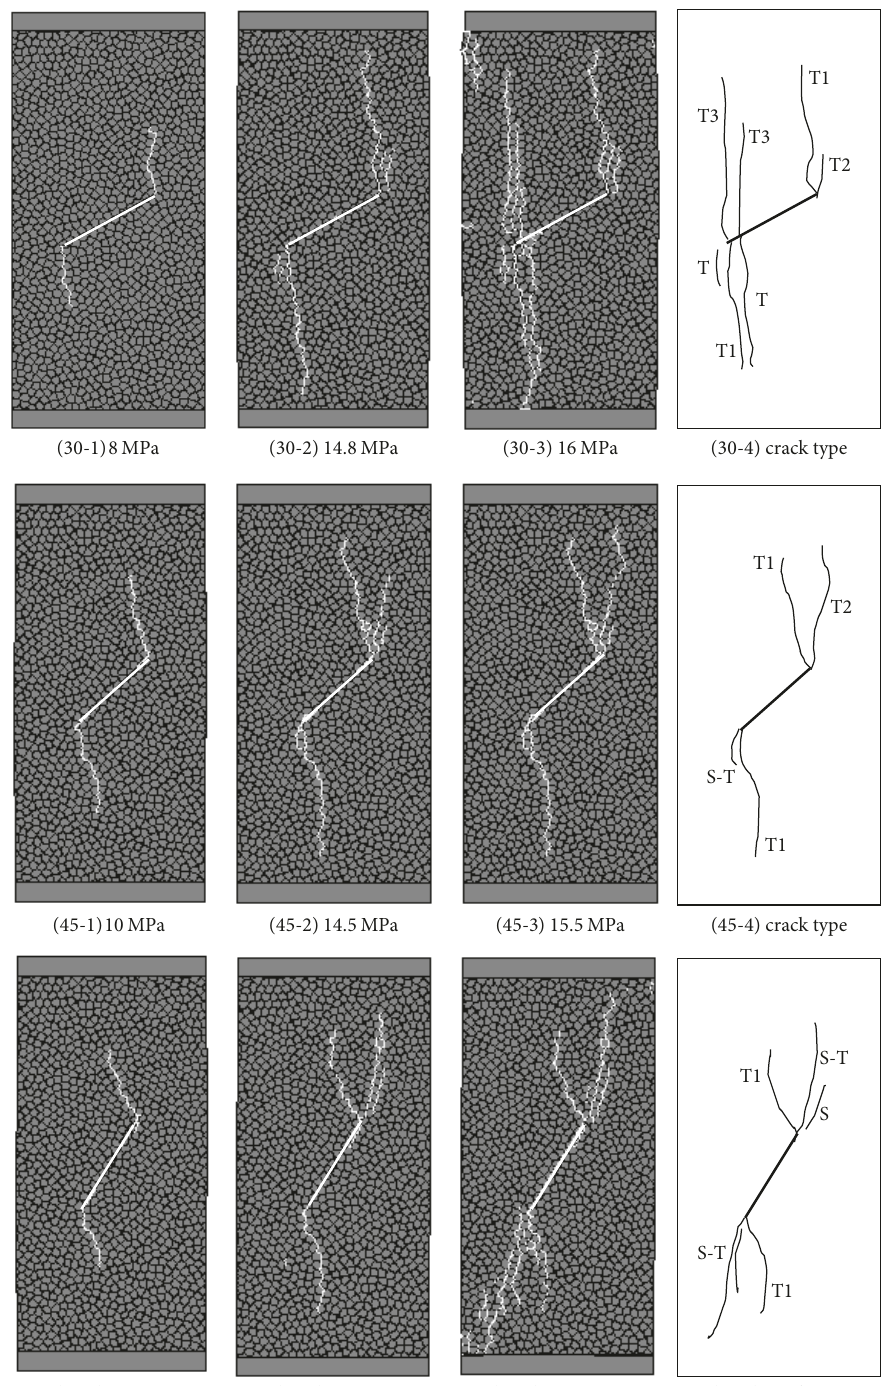
Figure 16: The failures modes at different inclination angles ( 𝛽 ). Length of the preexisting flaws is 30 mm. T: tensile crack, S: shear crack, and the number represents crack